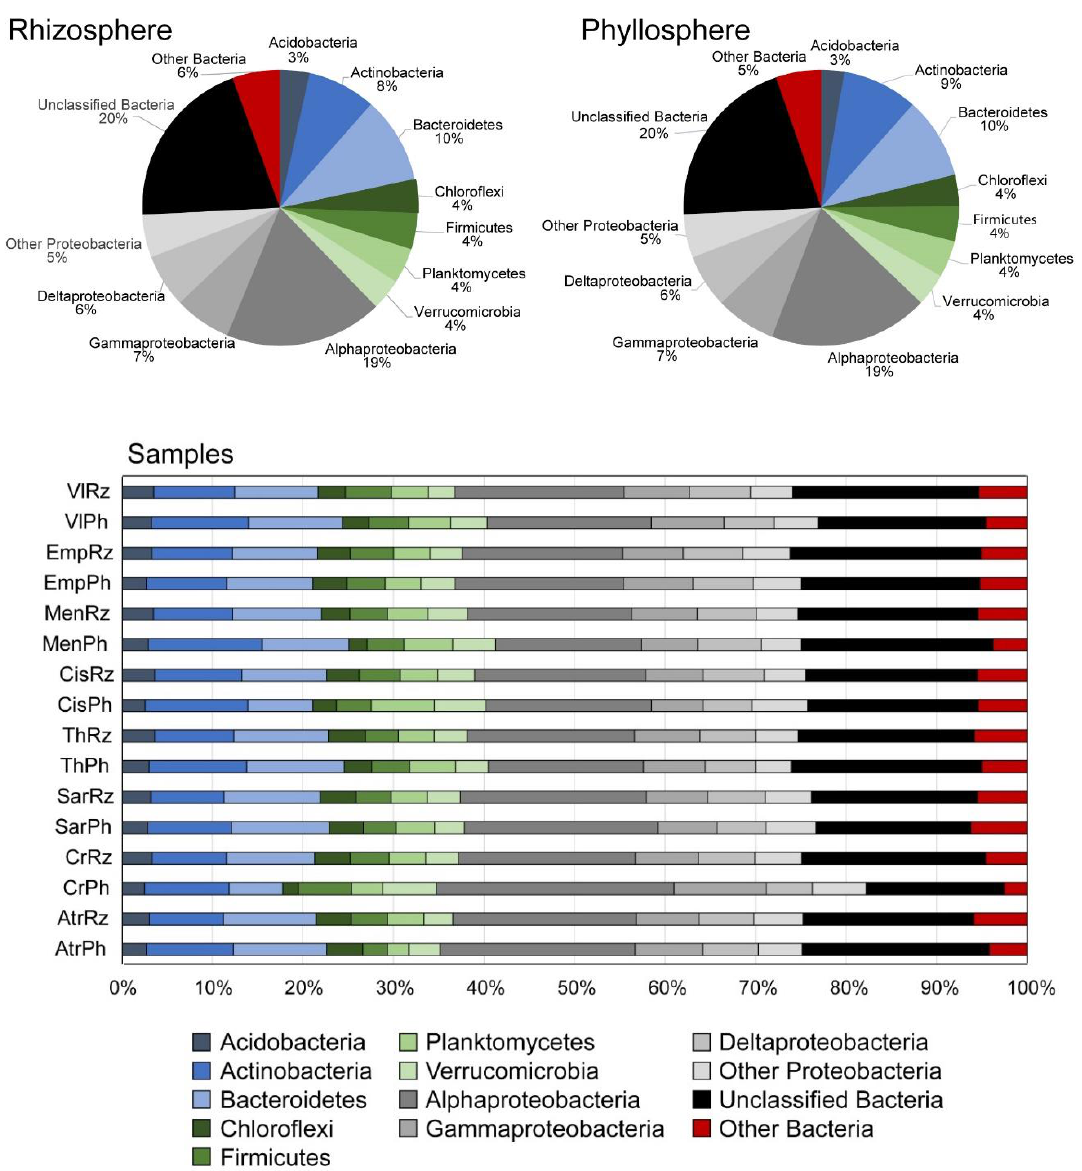
Figure 3. Top charts: Pies of the relative number of OTUs belonging to major high-level bacterial taxonomic groups in the rhizosphere and the phyllosphere of all samples. Bottom chart: Bars of the relative number of OTUs of the major high-level taxonomic groups in each plant regarding separately rhizosphere and phyllosphere samples. See Table 1 for coding assignments.